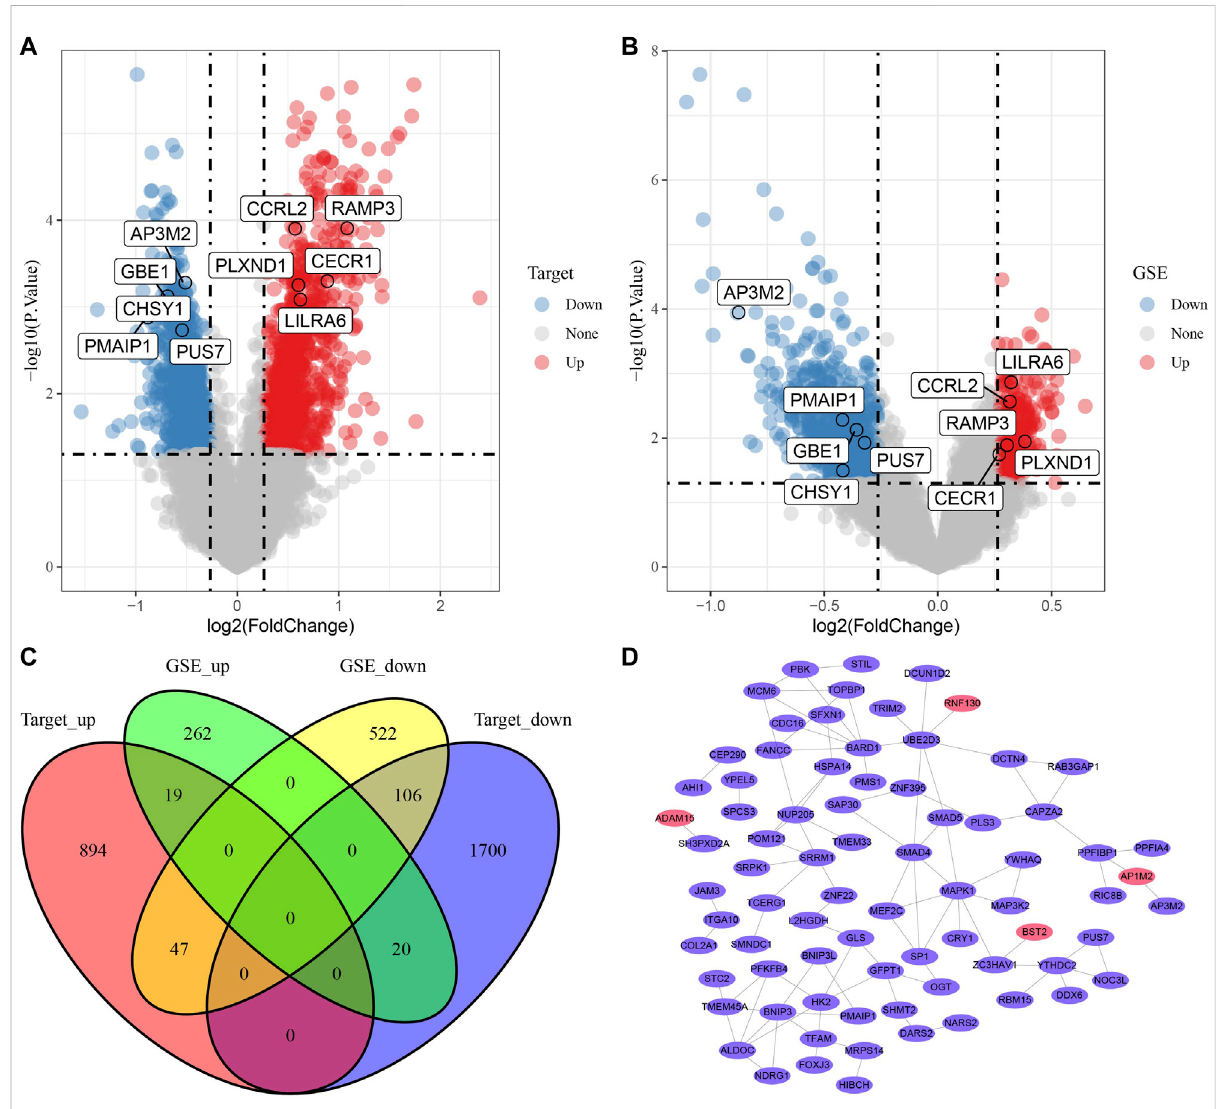
FIGURE 5 PPI of DEGs between metabolic subtypes. (A) : The volcano map of differentially expressed genes in cluster-1 and cluster-2 in Target data, red dots are up-regulated DEGs and blue dots are down-regulated DEGs. (B) : Differential expression analysis of two metabolic subtypes in merged GSE data sets. (C) : The Venn diagram shows the intersection of the Targets dataset and three GSE queues. (D) : The PPI network of 140 genes, the red ellipse represents the up-regulated DEGs and purple ellipse and the down-regulated